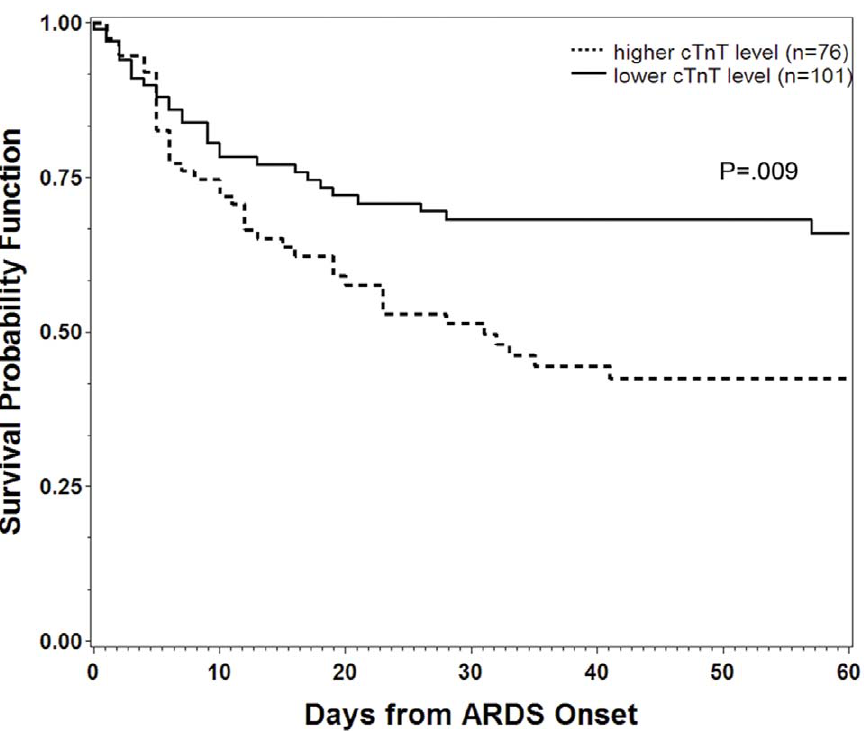
Figure 2. Survival time by cTnT stratum. (Patients stratified according to ROC-determined cutpoint of 0.036 ng/mL, P value stated for log-rank test).